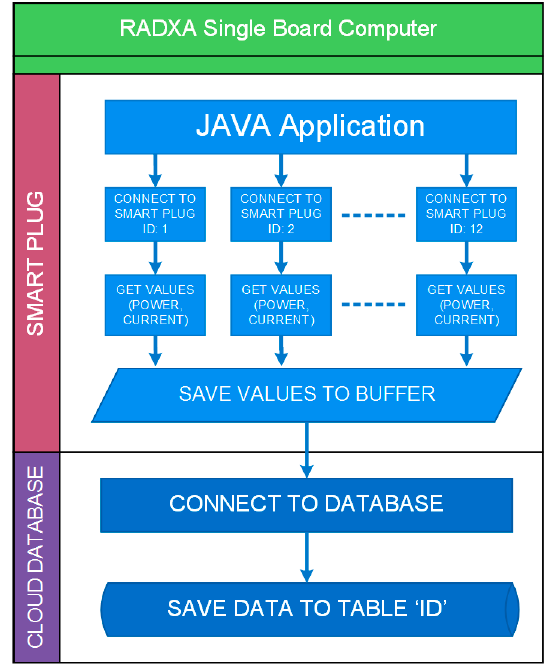
Figure 3. The flowchart of the monitoring and recording software.